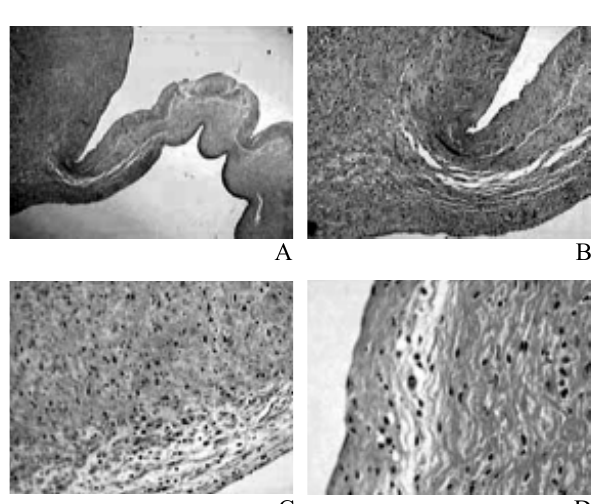
Fig. 4 - Análise histológica de heteroenxerto descelularizado explantado com 5 meses de evolução. A. Fotomicrografia demonstrando migração de fibroblastos na matriz, já invadindo pelo menos 50% da cúspide valvar. Notar a preservação da estrutura trilaminar da matriz colágena. Coloração HE 20X. B, C e D. Mesma lâmina com aumentos progressivamente